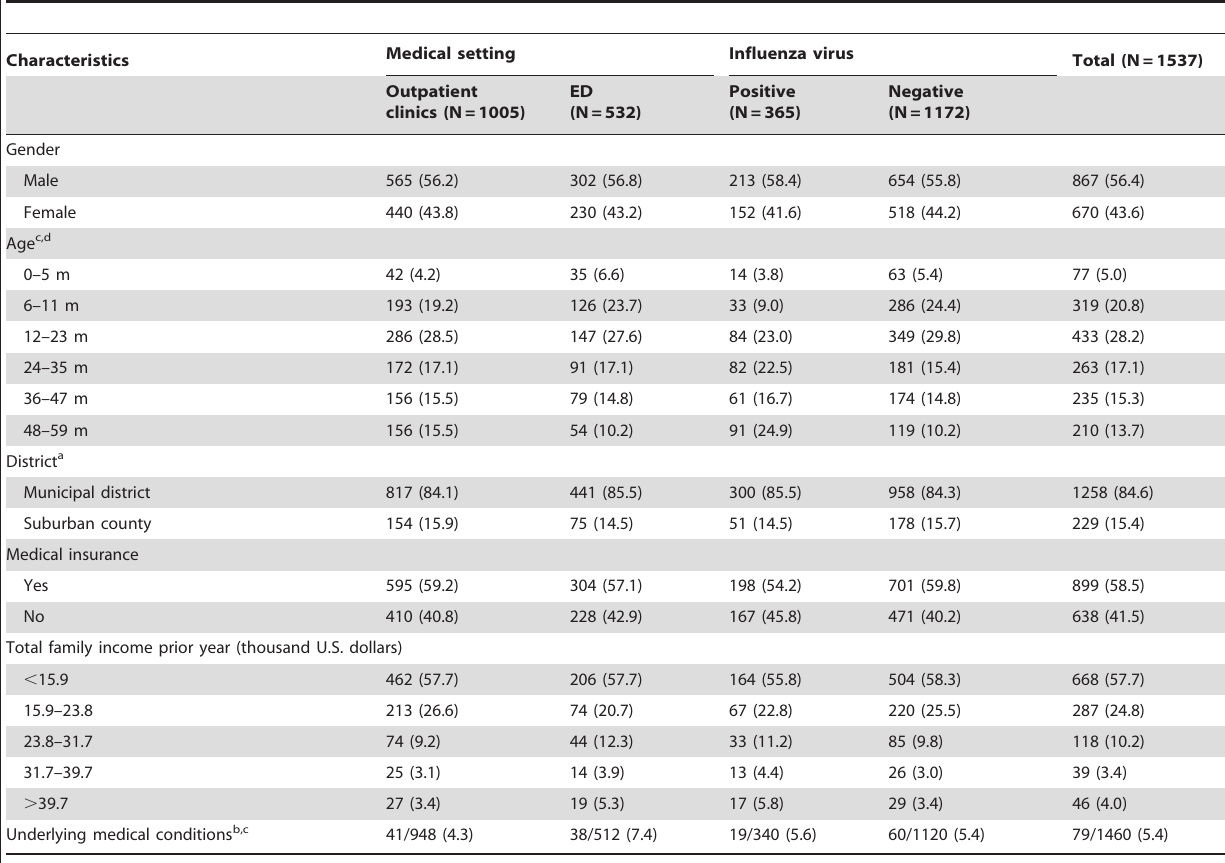
Table 1. Characteristics of enrolled influenza-like illness (ILI) cases, by medical setting and influenza virus status, n (%).